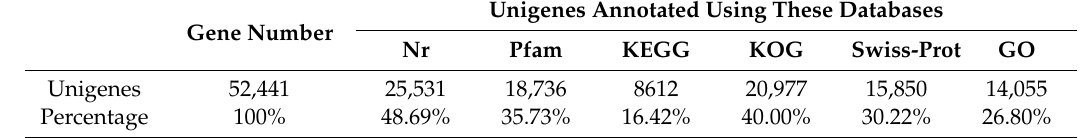
Table 1. Functional unigene annotations